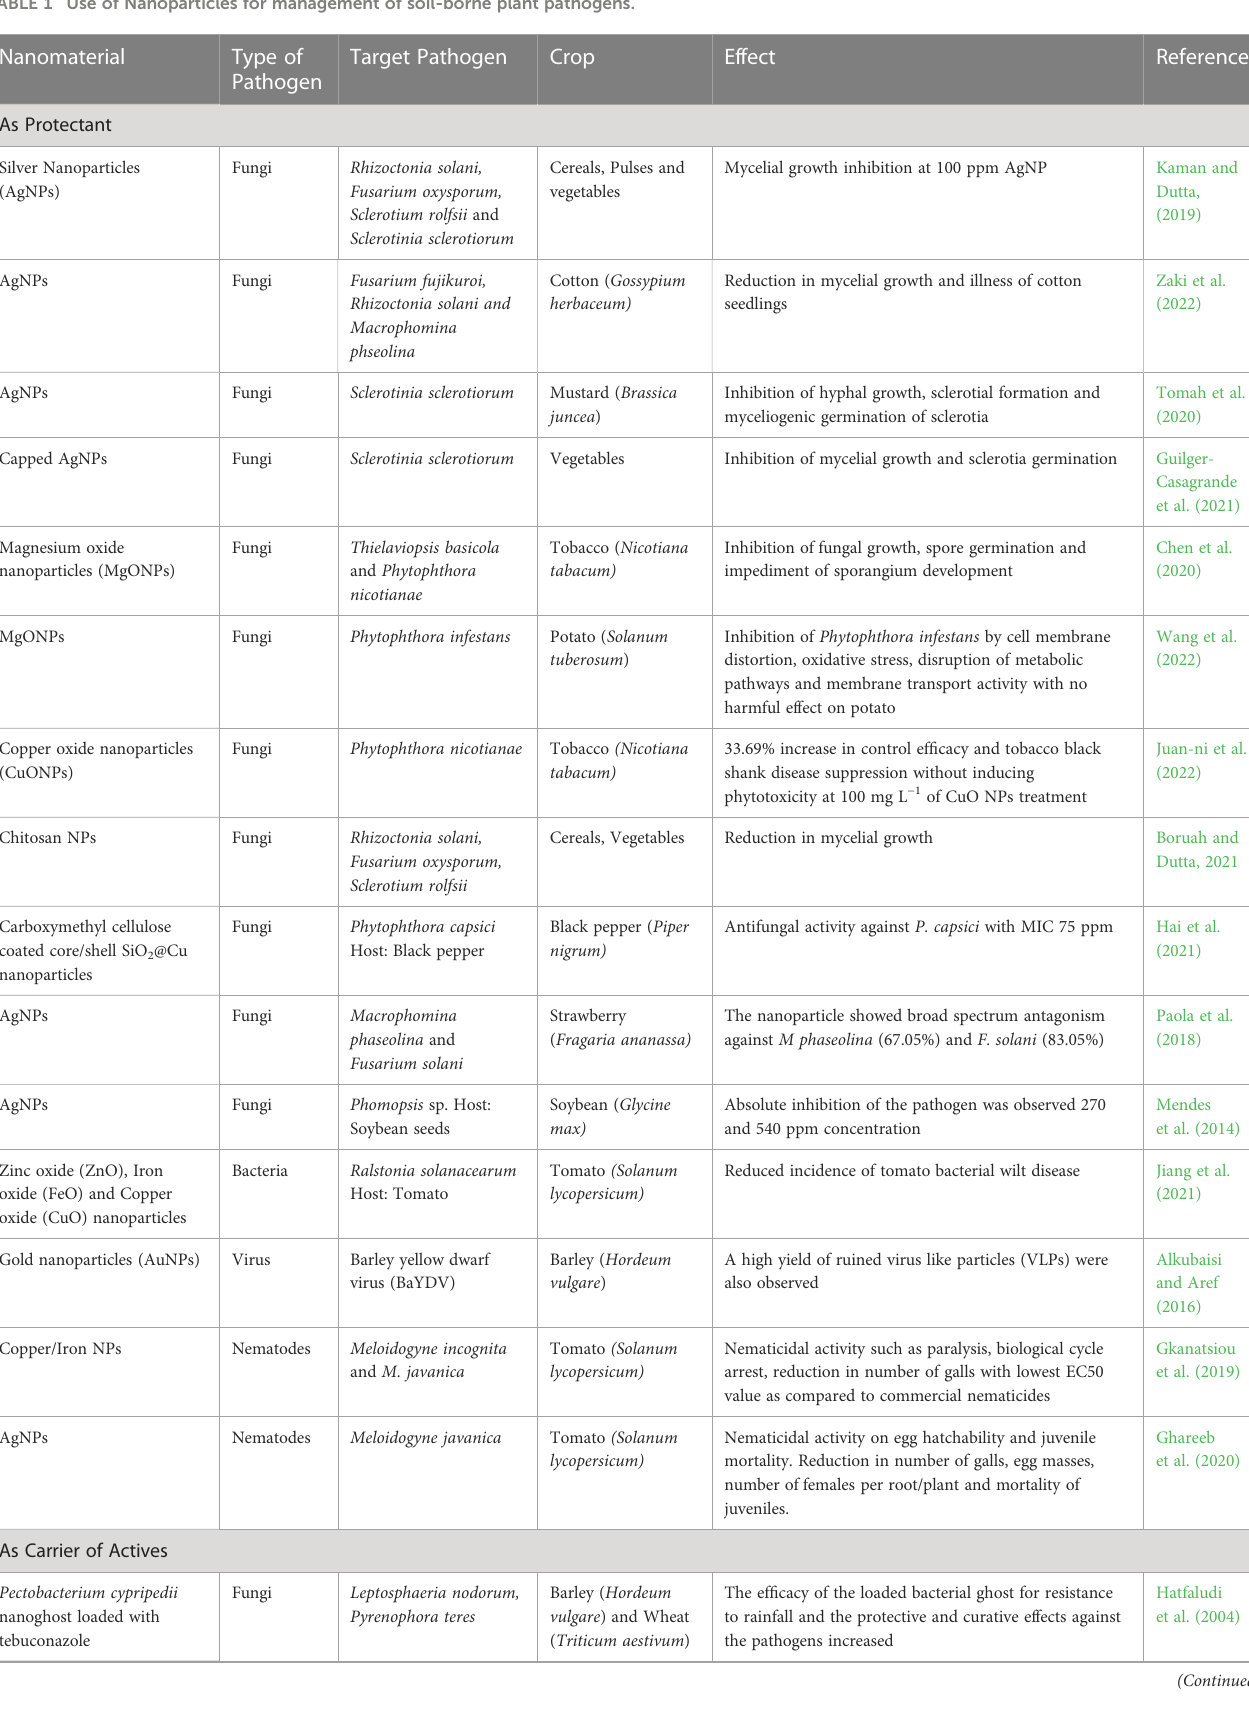
TABLE 1 Use of Nanoparticles for management of soil-borne plant